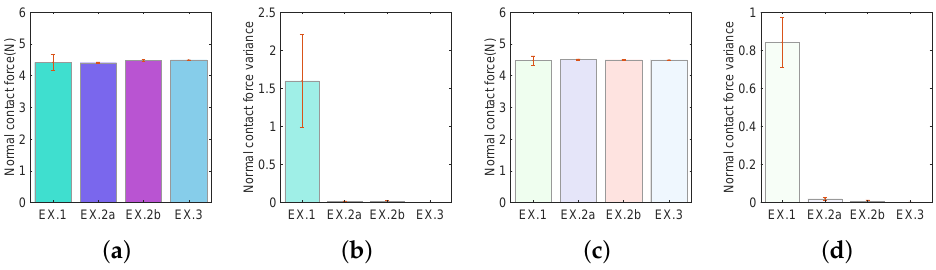
Figure 8. Bar chart for normal contact force and variance. ‘EX.1’, ‘EX.2a’, ‘EX.2b’, ‘EX.3’ represent Experiments 1, 2a, 2b, and 3, respectively. ( a ) Mean in p HRI mode. ( b ) Variance in p HRI mode. ( c ) Mean in tele HRI mode. ( d ) Variance in tele HRI